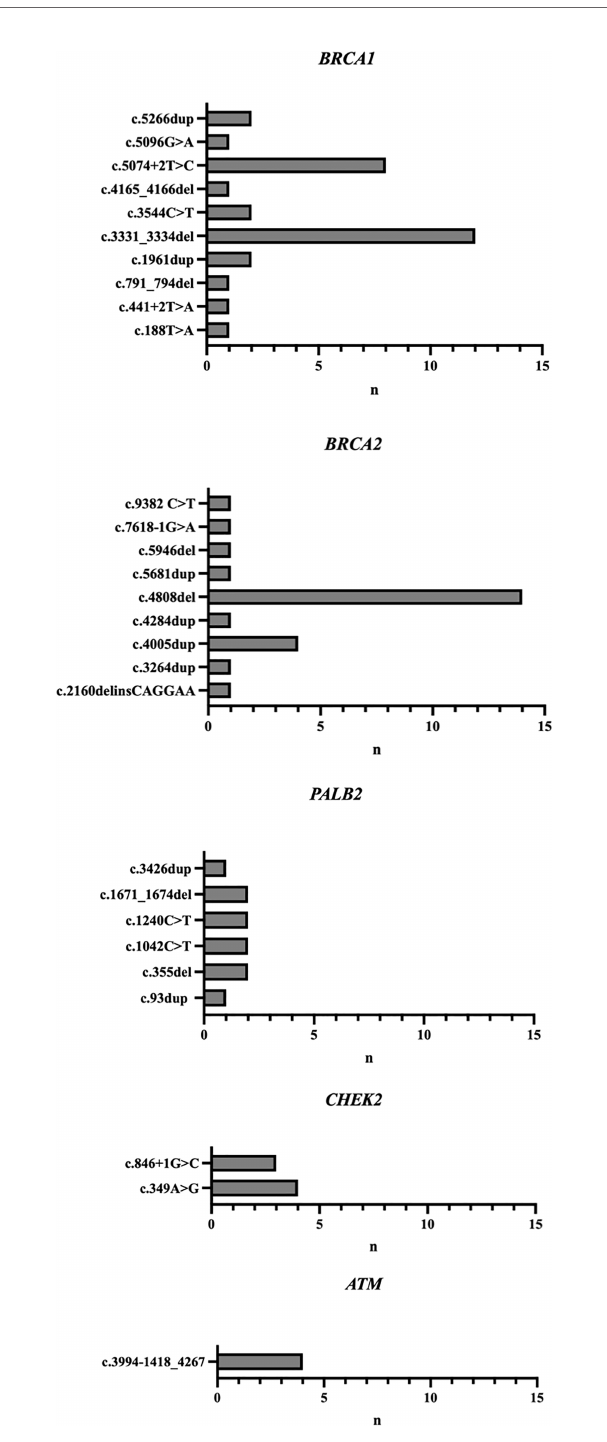
FIGURE 3 | P/LP variants in fi ve most frequently mutated